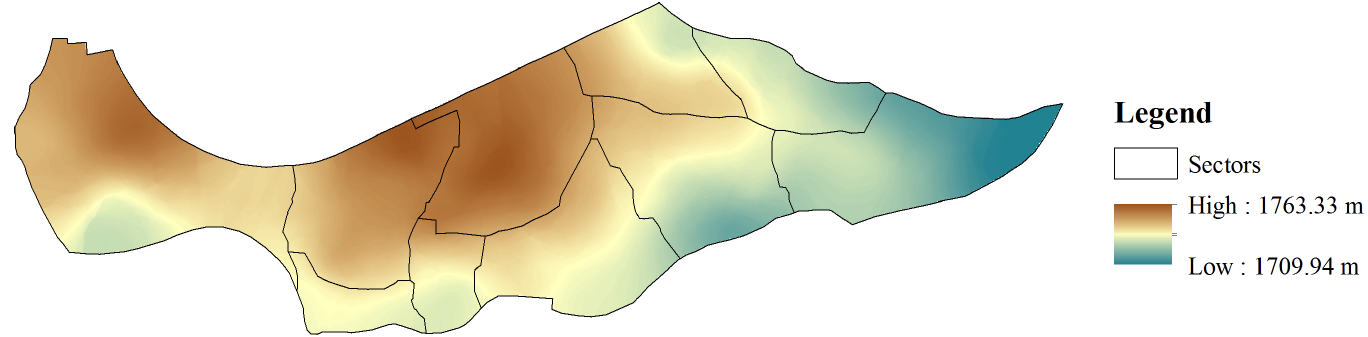
Fig 1. Household elevation surface interpolation generated using kriging